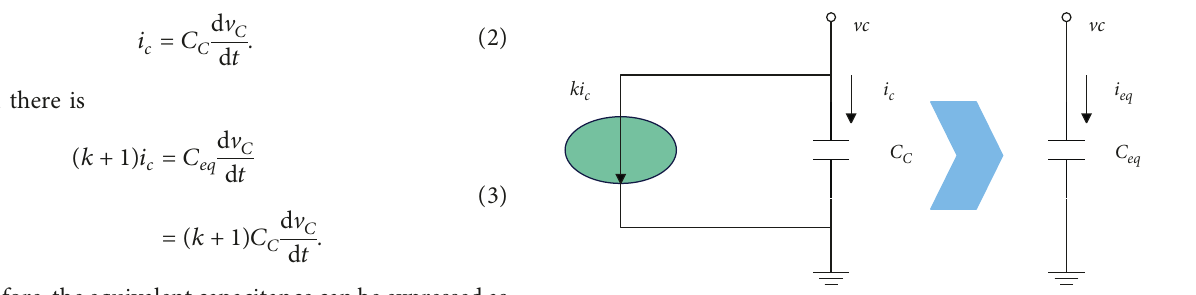
Figure 3: Schematic diagram of the realization of the capacitance multiplier